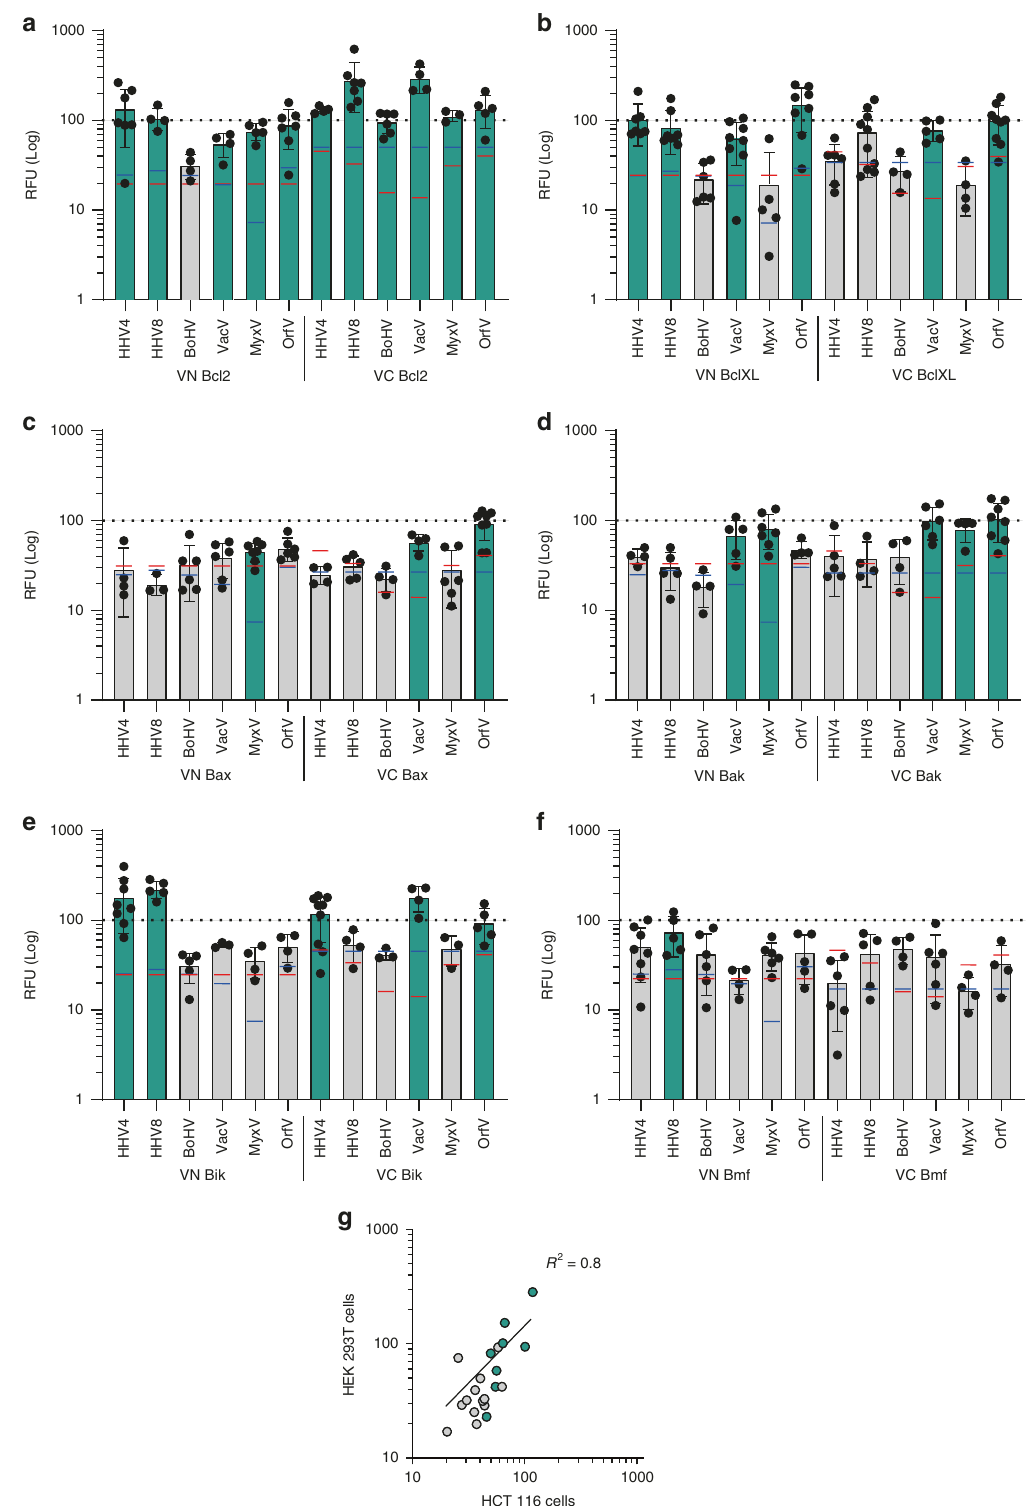
Fig. 3 Hetero-oligomerization in Eukaryotic membranes. a – f Relative fl uorescence (RFU) for the hetero-oligomerization of vBcl2 and cBcl2 TMDs. The mean and standard deviation of at least three independent experiments are shown. Solid dots represent the results of individual experiments ( n ranges between 3 and 10). The TMD included in the VFP chimeras (VN or VC) is indicated below each bar. The GpA TMD homodimer was used as a positive control and as the normalization value (dotted line). The interactions of each partner in the hetero-oligomers with T20 TMD were used as negative controls (i.e., X /T20 and T20/ Y for the X / Y interaction). The blue (VN/T20 TMD) and red (VC/T20 TMD) lines within each bar indicate the fl uorescence of the controls. An interaction (highlighted in green) was considered only if the RFU obtained was signi fi cantly higher (two-tailed homoscedastic t -test, p - value < 0.05) than those of both negative controls. g Correlation of the BiFC assay results in HCT 116 and HEK 293T cells. Green dots indicate interactions in HEK 293T cells. A linear trend line and the corresponding coef fi cient of correlation are